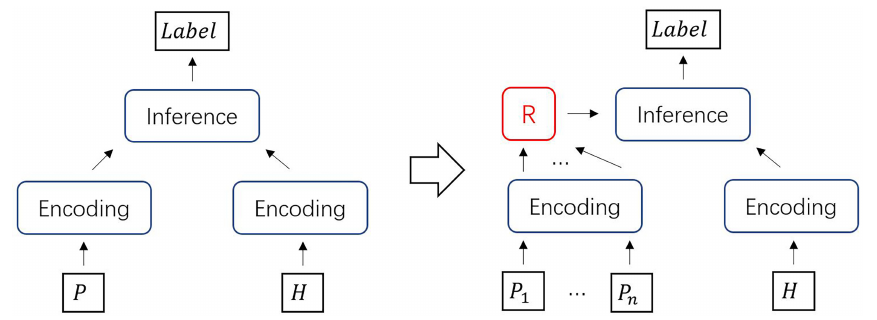
Figure 4. From SPE model to MPE